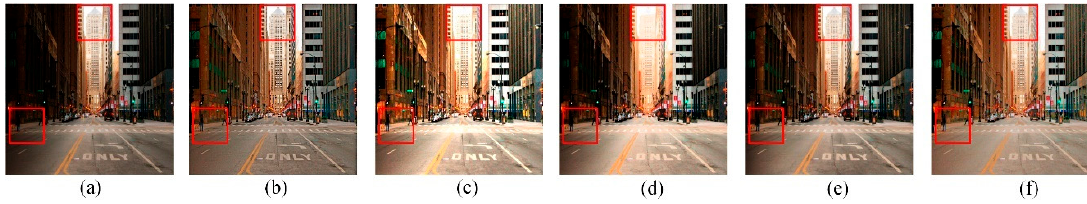
Figure 18. Urban image. ( a ) Original image; ( b ) result of Lee’s method; ( c ) result of LIME; ( d ) result of AGCWD; ( e ) result of SIRE; (f) result of the proposed method.